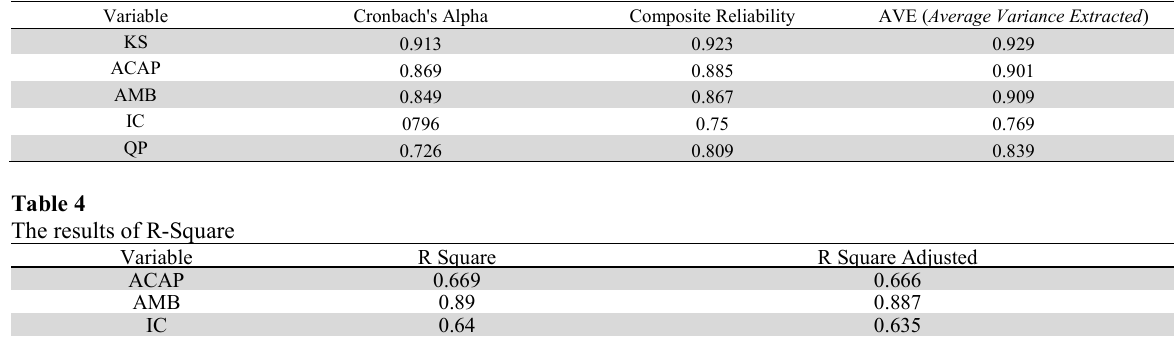
The results of composite reliability